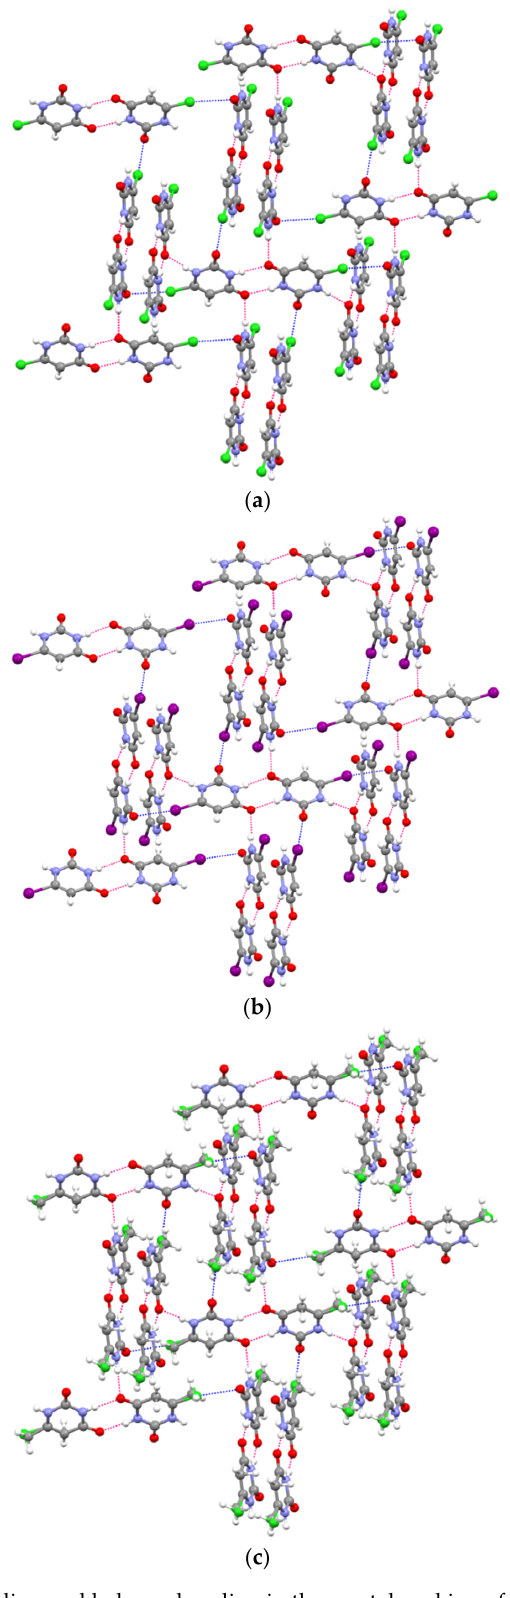
Figure 2. Hydrogen bonding and halogen bonding in the crystal packing of 6-halouracils. ( a ) 6Clura. ( b ) 6Iura. ( c ) 6Cl6Mura. Hydrogen bonds are shown as red dotted lines. Halogen bonds are shown as blue dotted